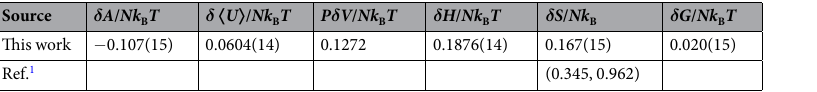
Table 2. Differences δ ≡ (bcc) − (hcp) in thermodynamic properties for the Sutton-Chen model defined in (I). “This work” indicates results as computed in this work, using property values for the systems of size N 6 for each phase. Entropy is reported in ref. 1 as a range of values, represented here by the pair of numbers in parentheses. A is the Helmholtz free energy; 〈 U 〉 is the energy; H is the enthalpy; S is the entropy; G is the Gibbs free energy, P = 360 GPa is the pressure, V / N is the volume per atom (6.65 Å 3 /atom for the bcc phase, and 6.616 Å 3 /atom for hcp). Numerals in parentheses indicate the estimated error (68% confidence) in the rightmost digit(s) of the reported